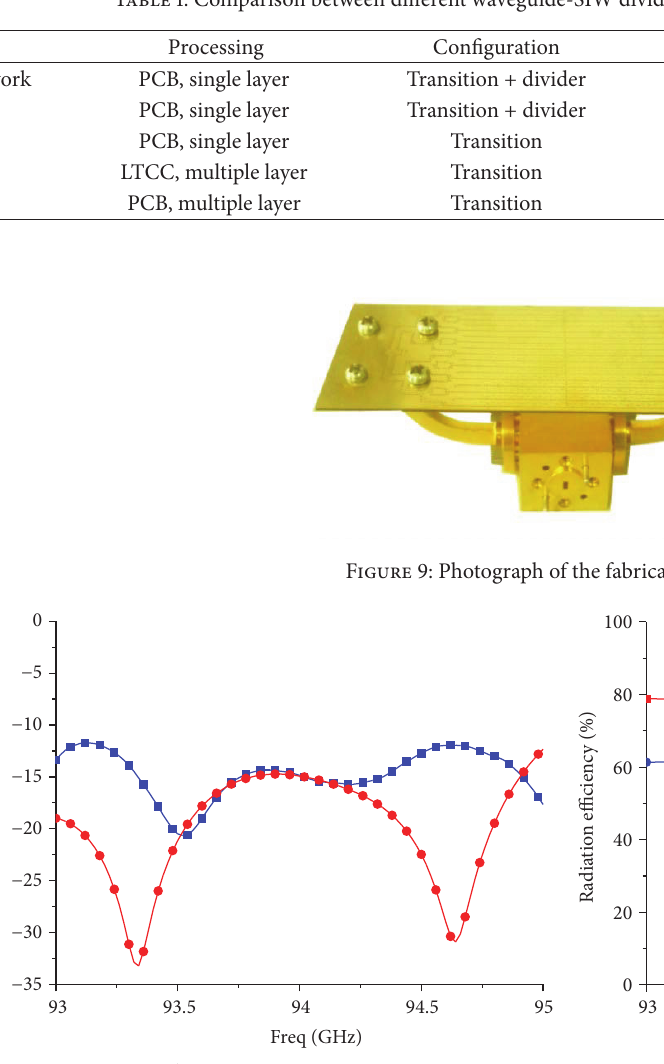
Table 1: Comparison between different waveguide-SIW dividers and waveguide-to-SIW transitions.